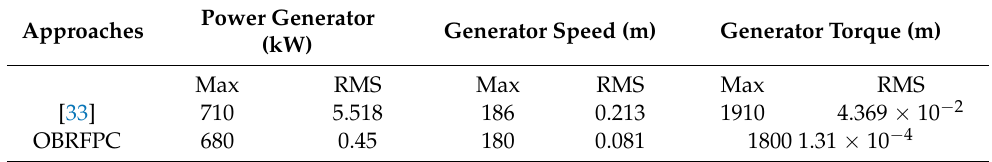
Table 2. RMS comparison of wind turbine responses with sensor